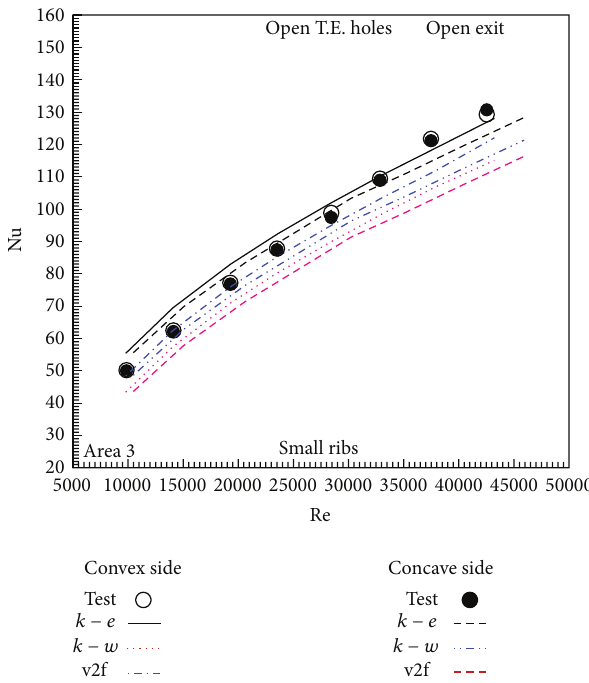
Figure 19: Comparison of the 𝜅 - 𝜀 , 𝜅 - 𝜔 , and V 2𝑓 turbulence models with the test results on the convex and concave walls (Area 3) for the case of open trailing-edge holes and open exit with small ribs.